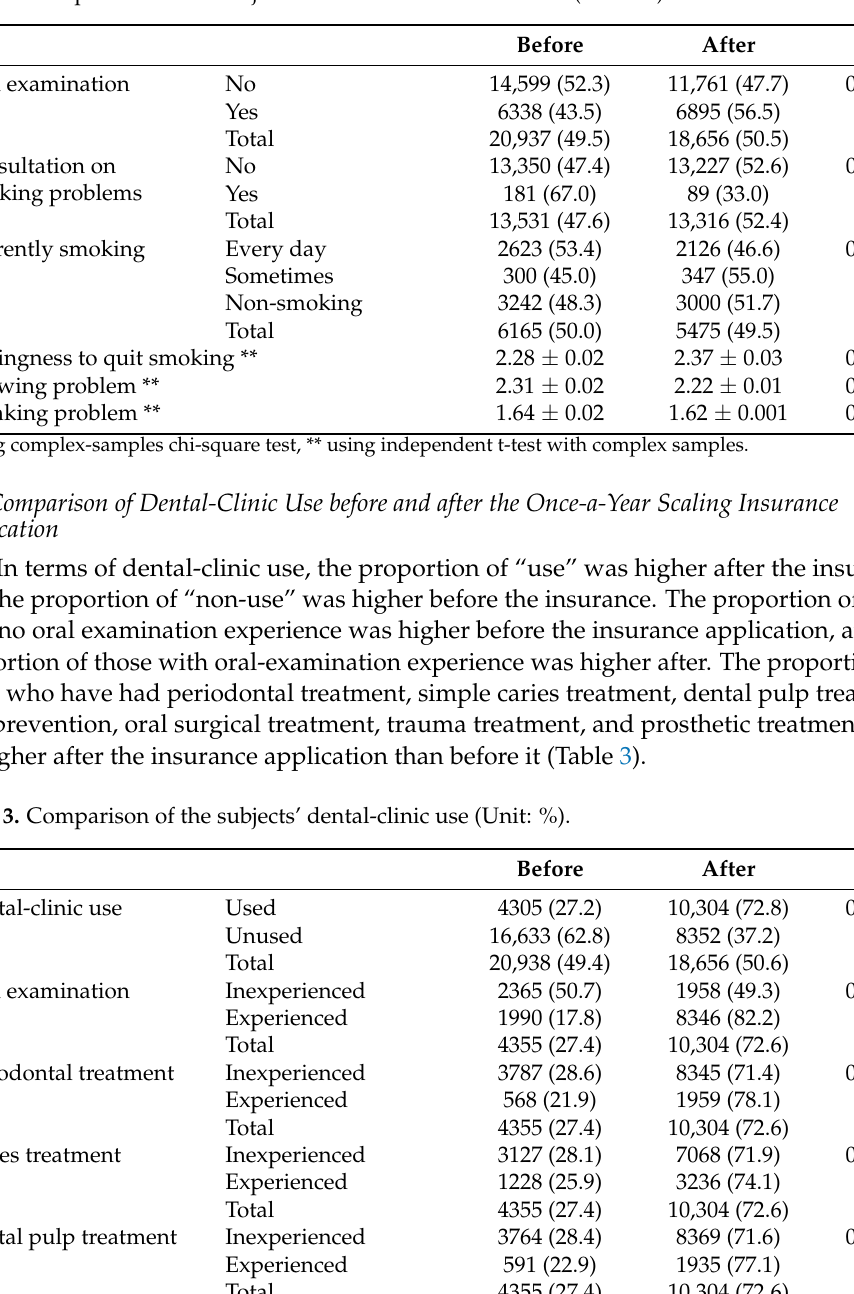
Table 2. Comparison of the subjects’ oral-related characteristics (Unit: %).